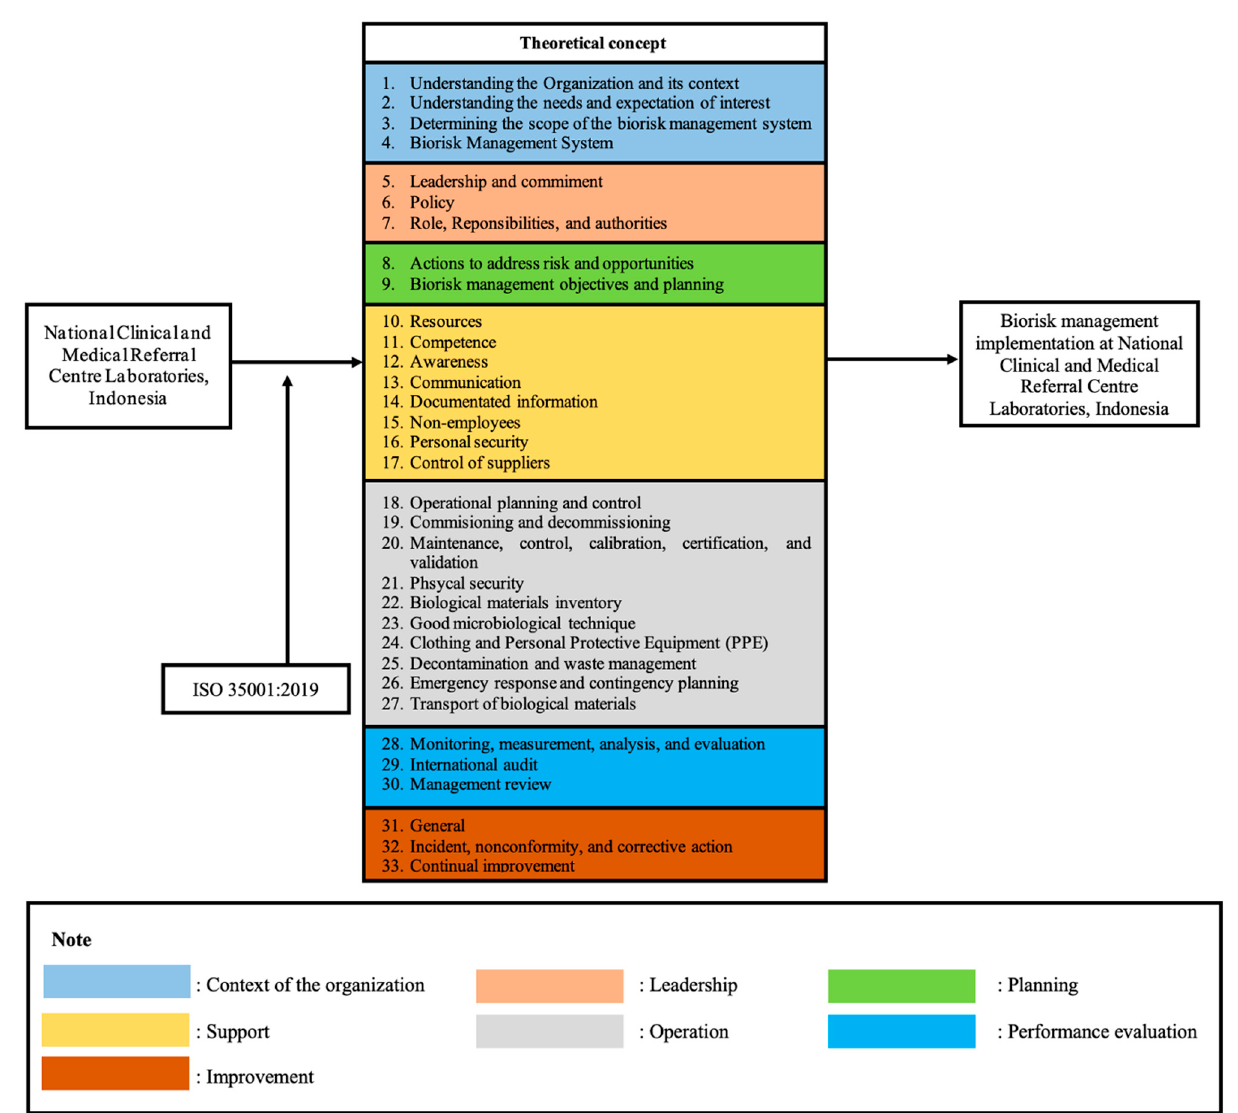
Figure 1. Theoretical concept.